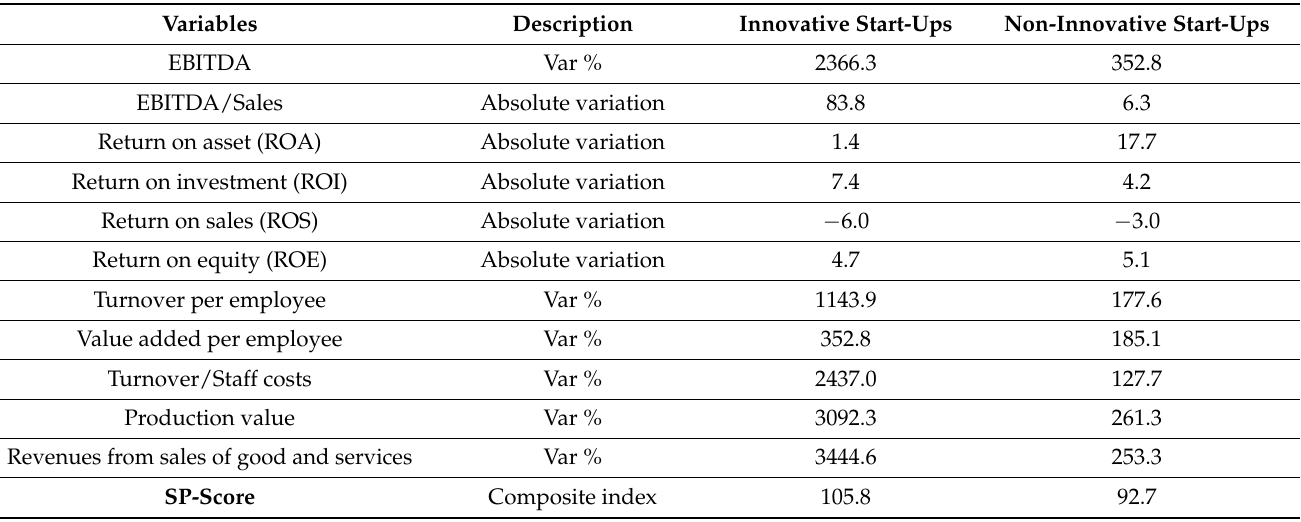
Table 3. Analysis of performance realized by the Innovative Italian start-ups (ISPs) and the Non- Innovative Start-ups (NISPs).